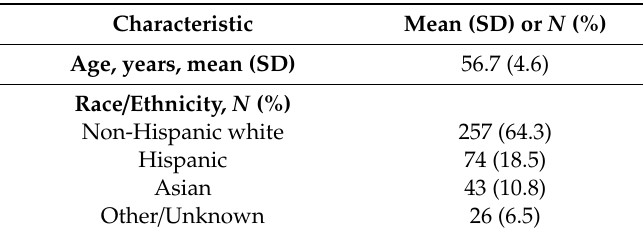
Table 2. Cohort characteristics for the MEE